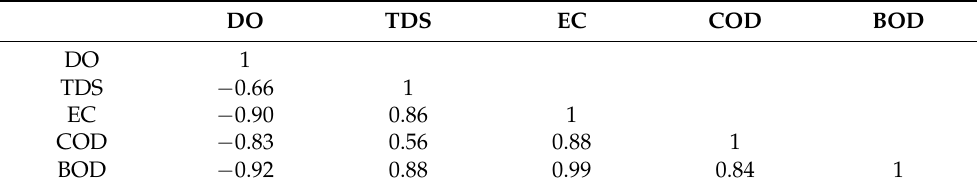
Table 2. Relationship among DO, TDS, EC, COD, and BOD in the raw wastewater.